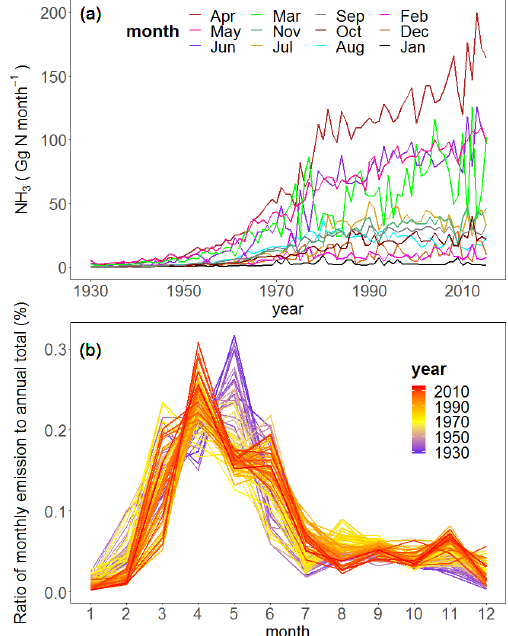
Figure 6. Temporal dynamics in monthly NH 3 emission (a) and share of each month to annual total (b) from 1930 to 2015. The month legend in (a) is vertically ordered by the NH 3 emission rate in 2015.